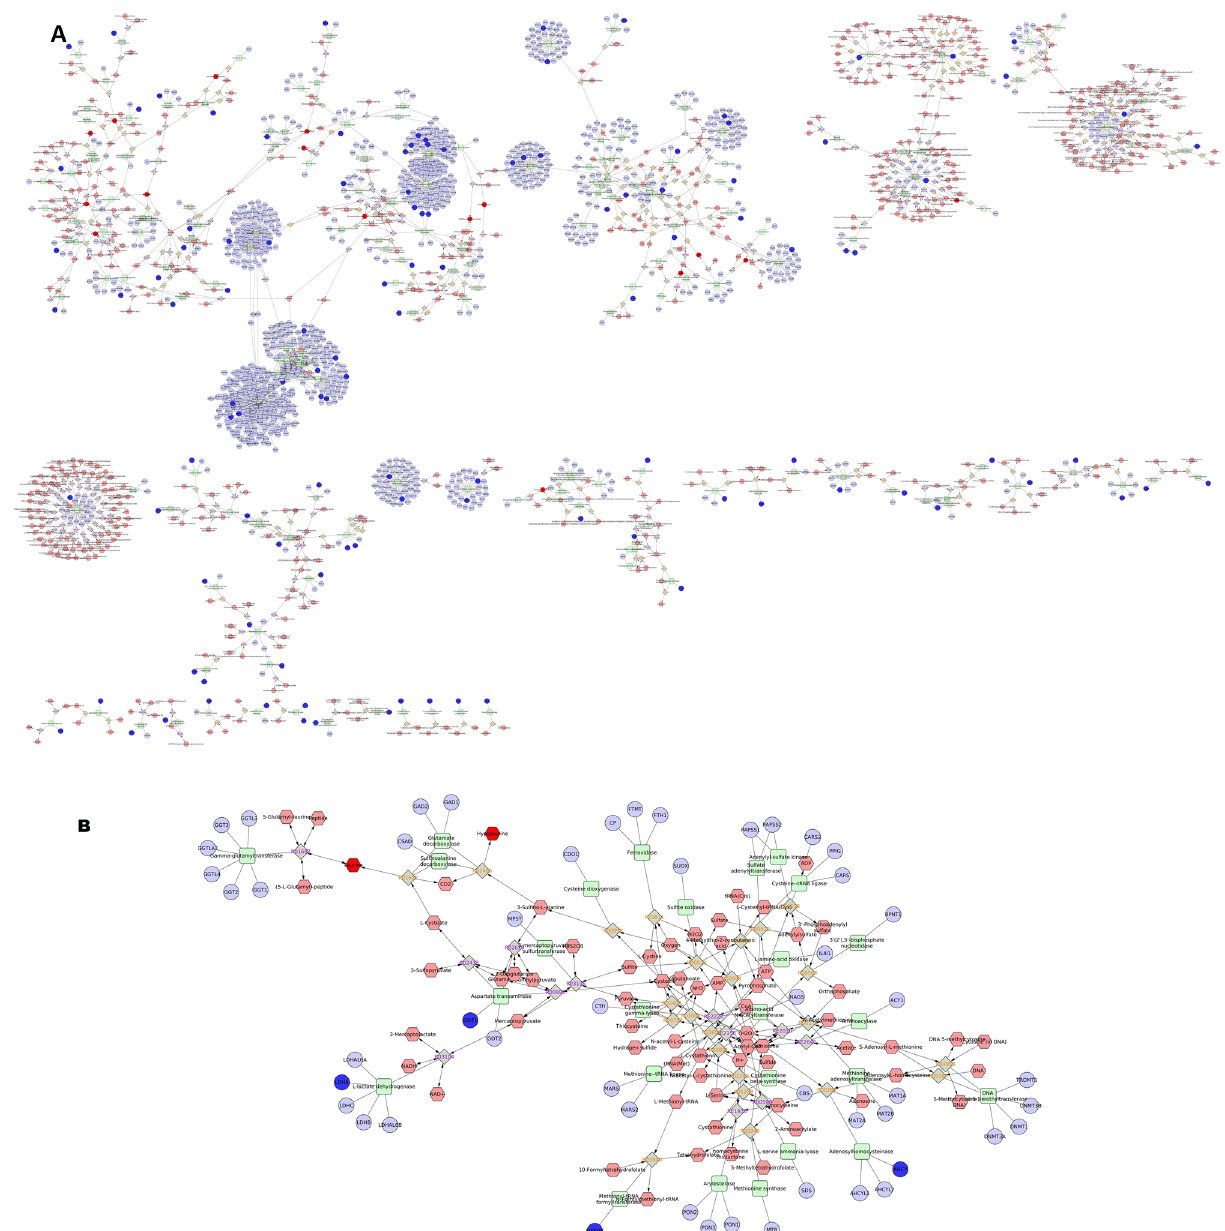
Figure 5. ( A ) Interaction network of dysregulated transcripts and metabolites. ( B ) Subnetwork of Methionine and cysteine